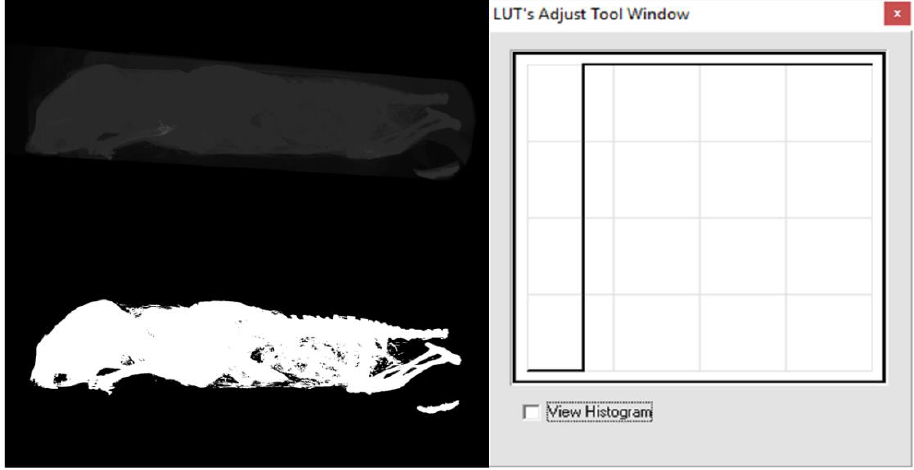
Figure 6. Example of a point operator (function) — thresholding or binarization [16].